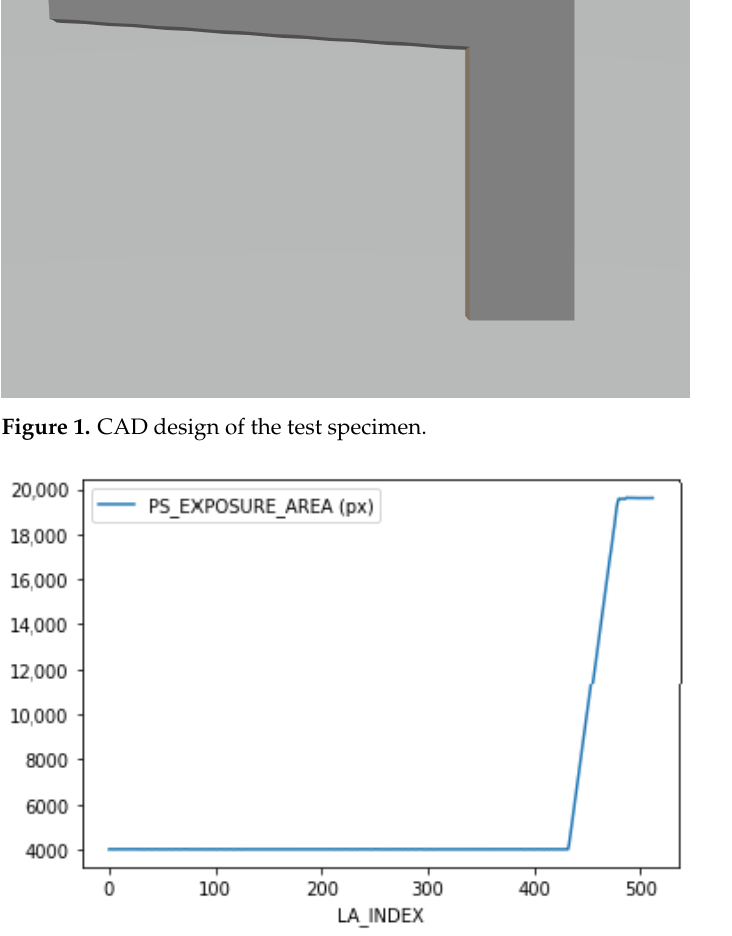
Figure 2. Area of a layer (No of pixels) exposed to laser power vs layer numbers of test